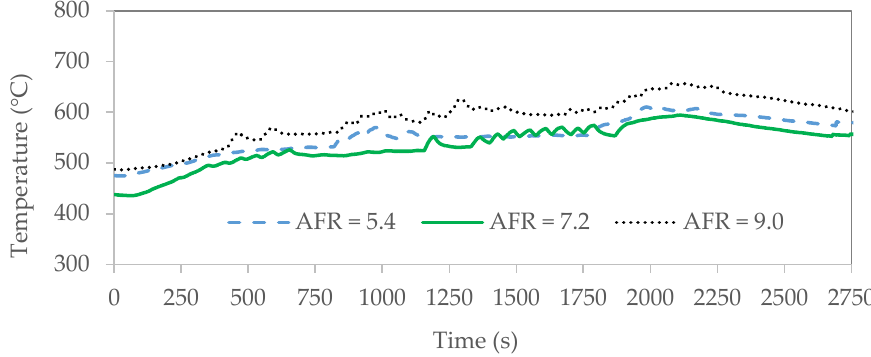
Figure 6. Trends in combustion chamber temperature on the upper side as determined by experiment.